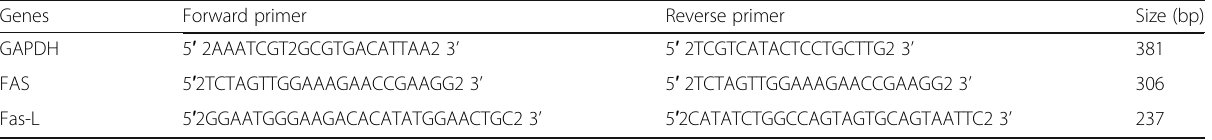
Table 1 Primers sequences used for real-time quantitative PCR Genes Forward